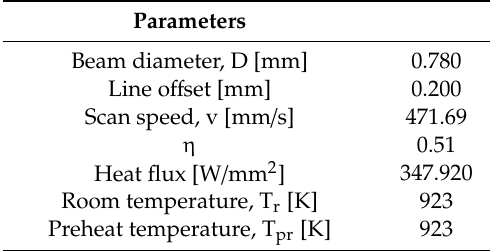
Table 2. Process parameters for the experiment and